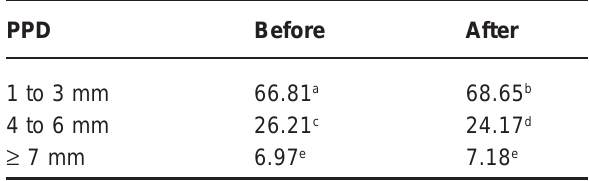
* different letters indicate statistically significant difference (P<0.05) detected with the paired t TABLE 2- Mean probing pocket depth – PPD and clinical attachment level - CAL (mm) of anterior and posterior teeth and of interproximal and non-interproximal sites before and 21 days after the beginning of supragingival plaque control TOOTH-SITES PPD CAL BEFORE AFTER BEFORE